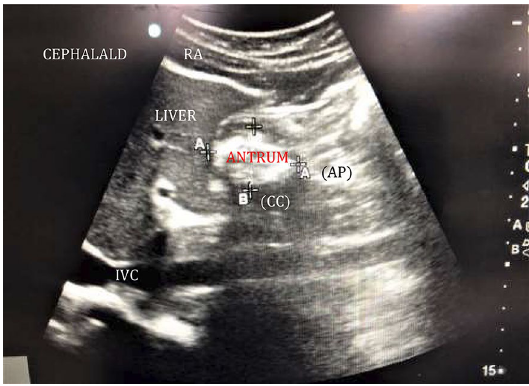
Fig. 3 Two diameter method—Anteroposterior (AP) and Craniocaudal (CC) measurements of antrum; RA (rectus